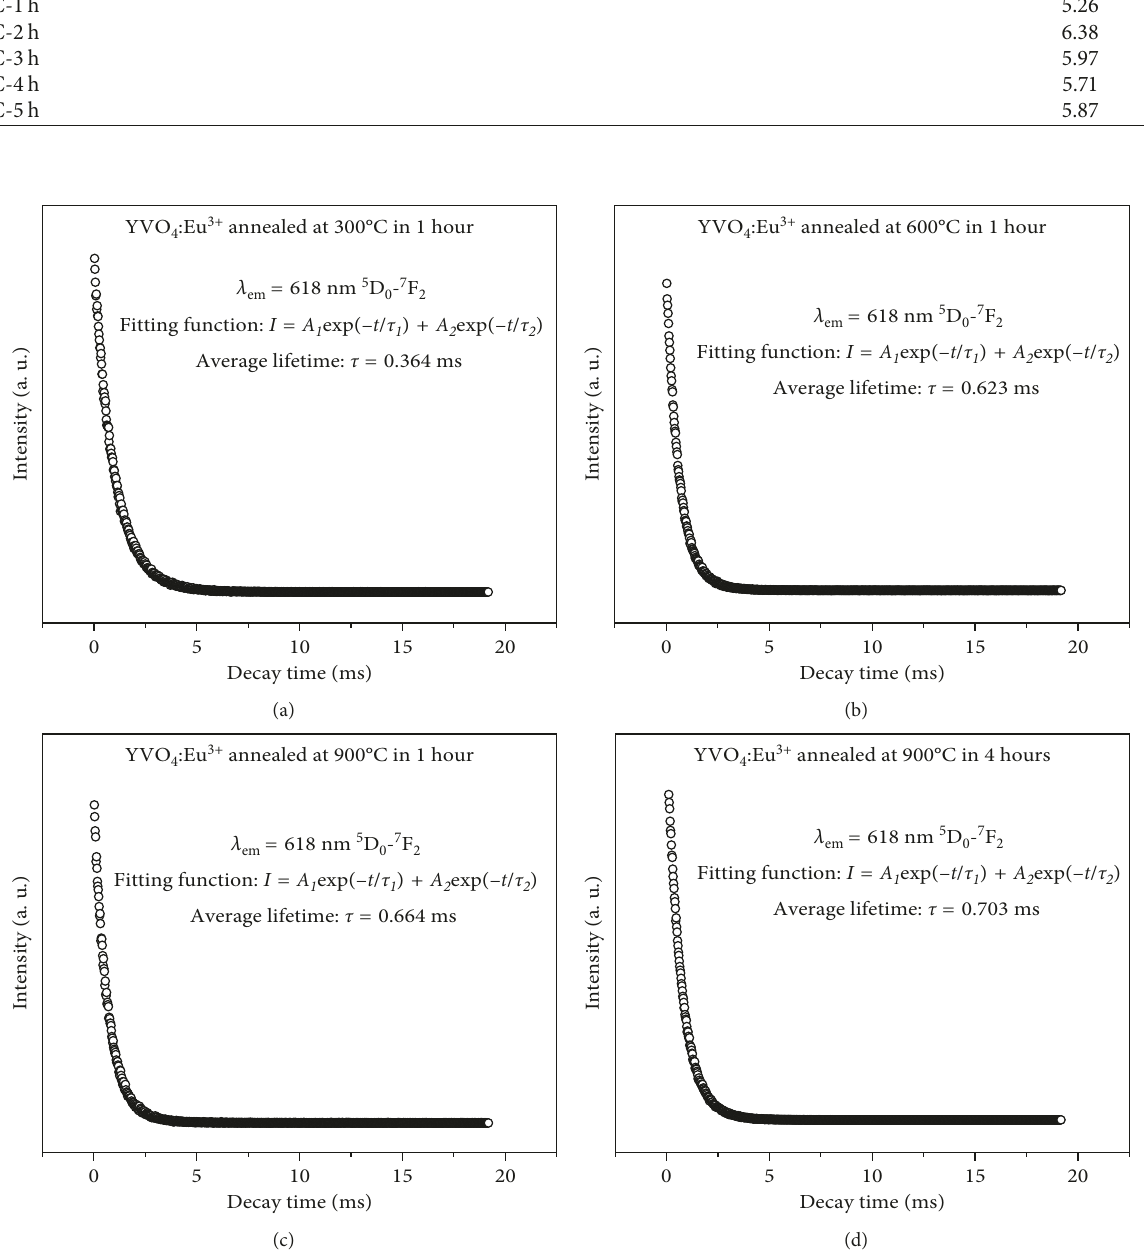
3+ under 275 nm excitation for YVO 0 excited state of Eu